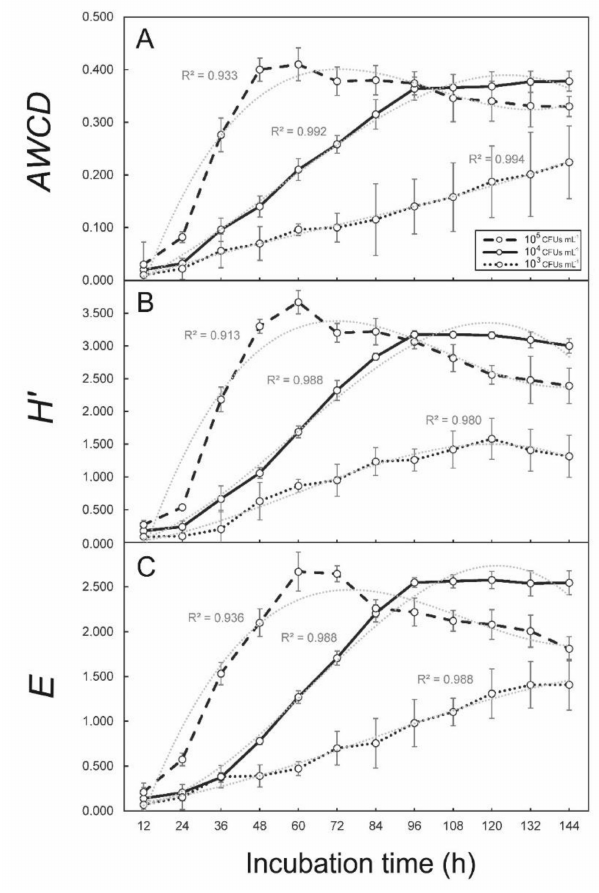
Figure 2. Mean values ( n = 5) ± SD of ( A ) AWCD , ( B ) H ’ and ( C ) E measured every 12 h during a 144-h incubation in di ff erent dilutions (~10 5 CFUs mL − 1 , dashed line; ~10 4 CFUs mL − 1 , continuous line; ~10 3 CFUs mL − 1 , dotted line) of soils from the experimental olive orchard. Na 4 P 2 O 7 • 10 H 2 O concentration was 1.8% ( w / v ). The R 2 values and the respective trend lines (dotted lines in grey) were calculated on the basis of a polynomial function of degree